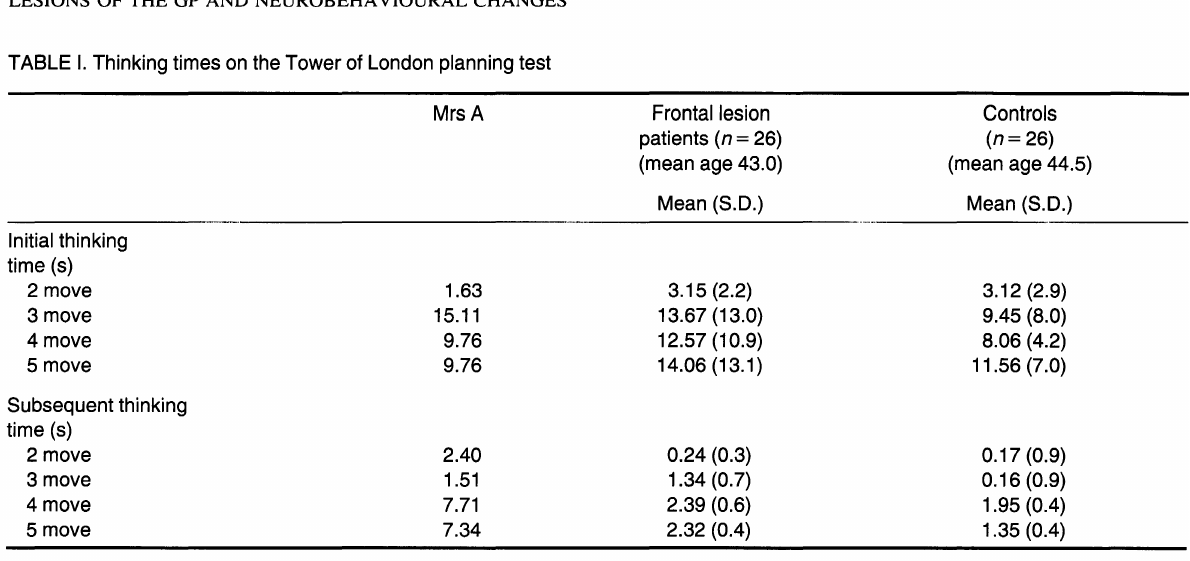
TABLE I. Thinking times on the Tower of London planning test